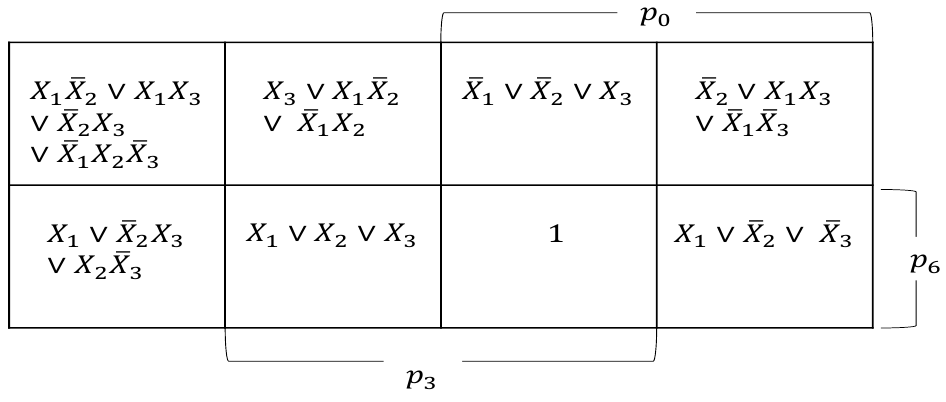
Fig. 17. Listing of all particular solutions of Example